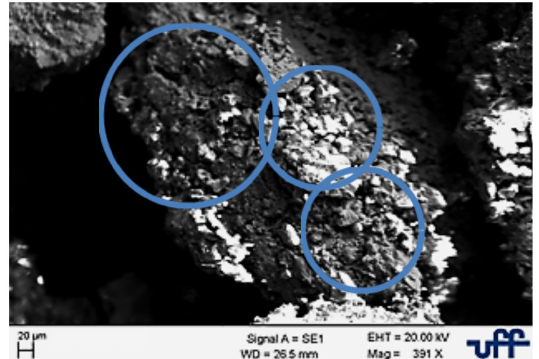
Figure 4. Micrograph of iron ore particles after application of microwave energy. (appud Silva et al) 12